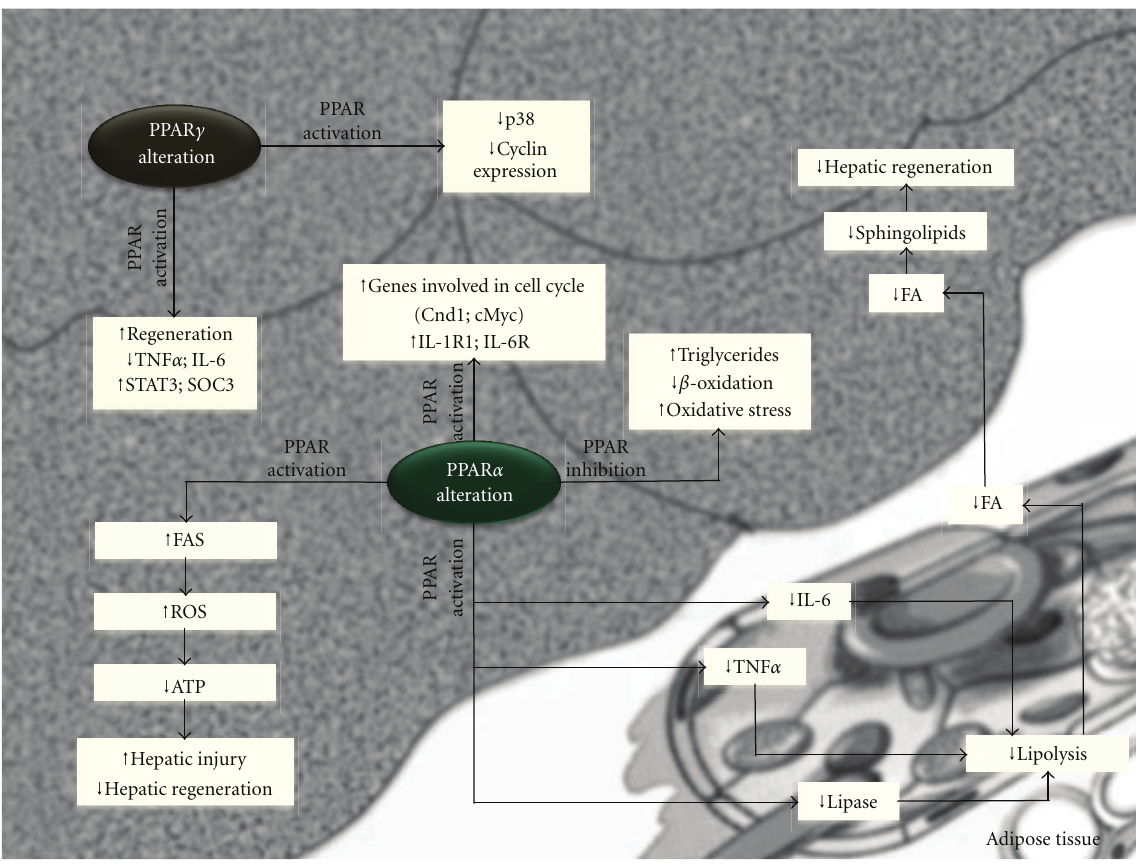
Figure 3: PPAR and hepatic regeneration. Adenosine triphosphate: ATP; fatty acid: FA; interleukin-1 receptor: IL-1R; interleukin-6: IL-6; interleukin-6 receptor: IL-6R; tumor necrosis factor-alpha: TNF- α ; signal transducer and activator of transcription 3: STAT3; suppressor of cytokine signalling 3: SOC3; reactive oxygen species: